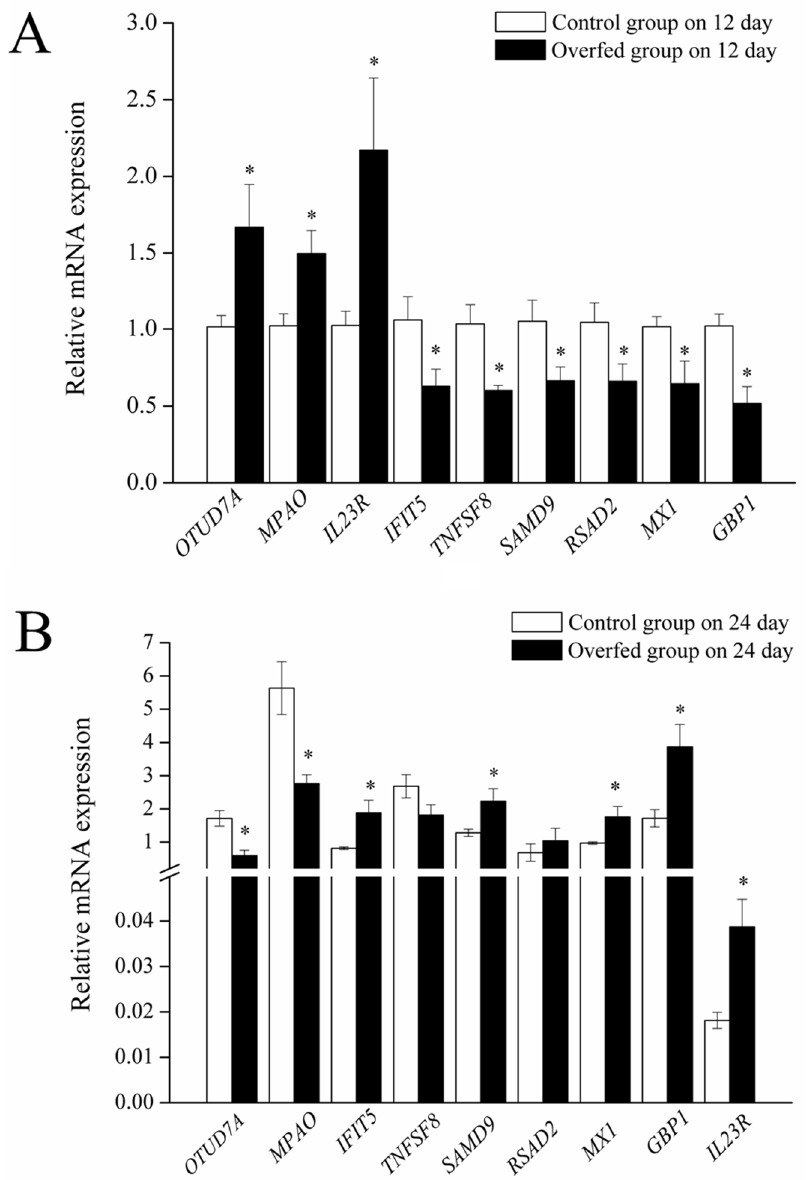
Figure 4. Effects of overfeeding on expression of downstream genes. Control group denotes geese that were fed normally; overfed group denotes geese subjected to 12 ( A ) and 24 days ( B ) of overfeeding; * p < 0.05. Samples in the control group on day 12 of overfeeding were used as calibrators for all groups. Six replicates were evaluated for each treatment. Data are shown as the mean ± SEM.